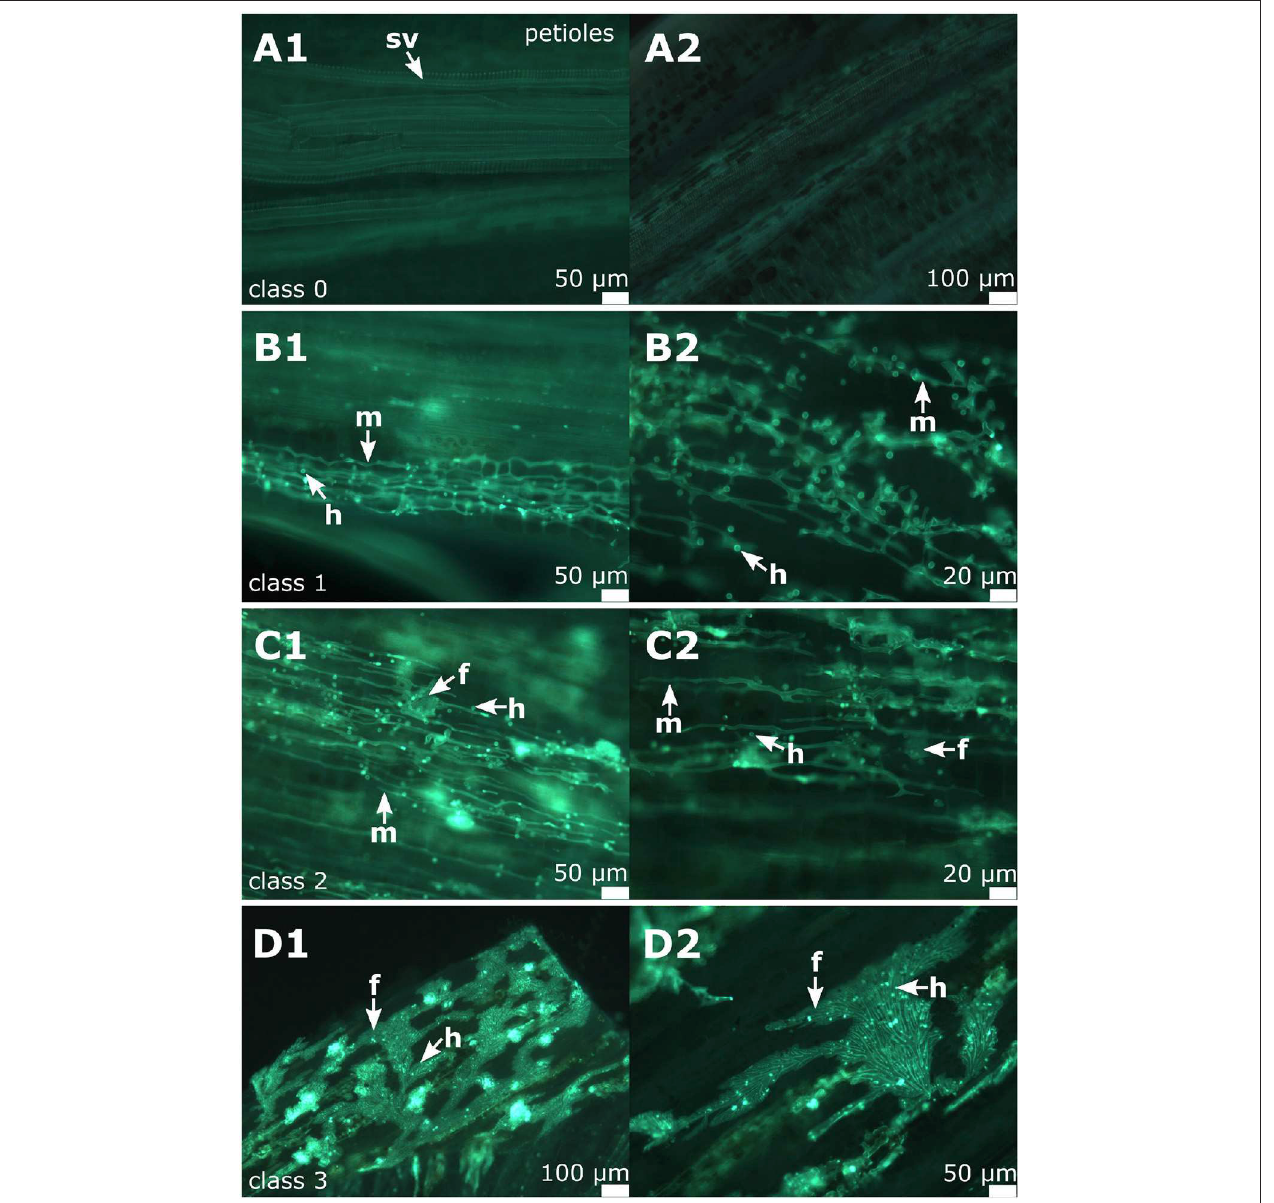
FIGURE 6 | Classification of the degree of infection in petioles. All these example images are from “Pinot noir.” (A1,A2) Microscopic image of non-infected petioles (class 0) showing the vascular tissue and surrounding cortical cells. (B1,B2) shows microscopic images of infected petioles assigned to class 1. (C1,C2) An example of class 2 associated with the formation of fan-shaped hyphae. (D1,D2) Samples assigned to class 3 as characterized by the presence of ubiquitous fan-shaped hyphae distributed all over the petioles. m, mycelium; f, fan-shaped hyphae; h, haustoria; sv, spiral vessel.